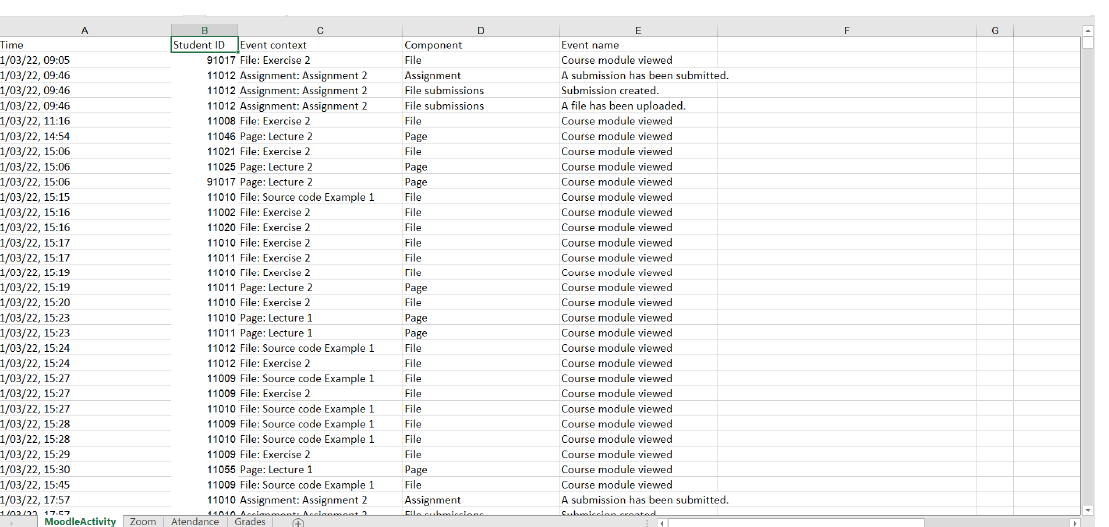
Figure 2. Data from Zoom. Figure 3. Final dataset.